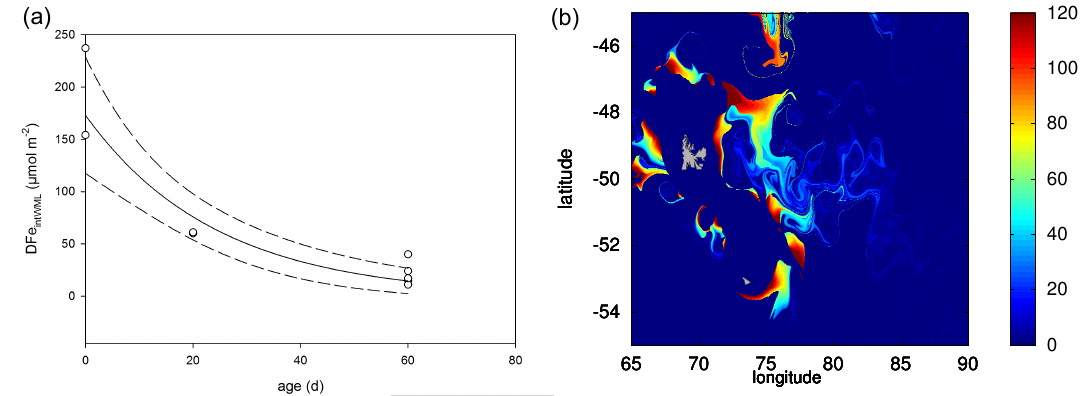
Figure 9. (a) Comparison with in situ iron measurements. (b) Estimation of the iron field (µmolm − 2 ) by merging in situ observations and altimetry-derived